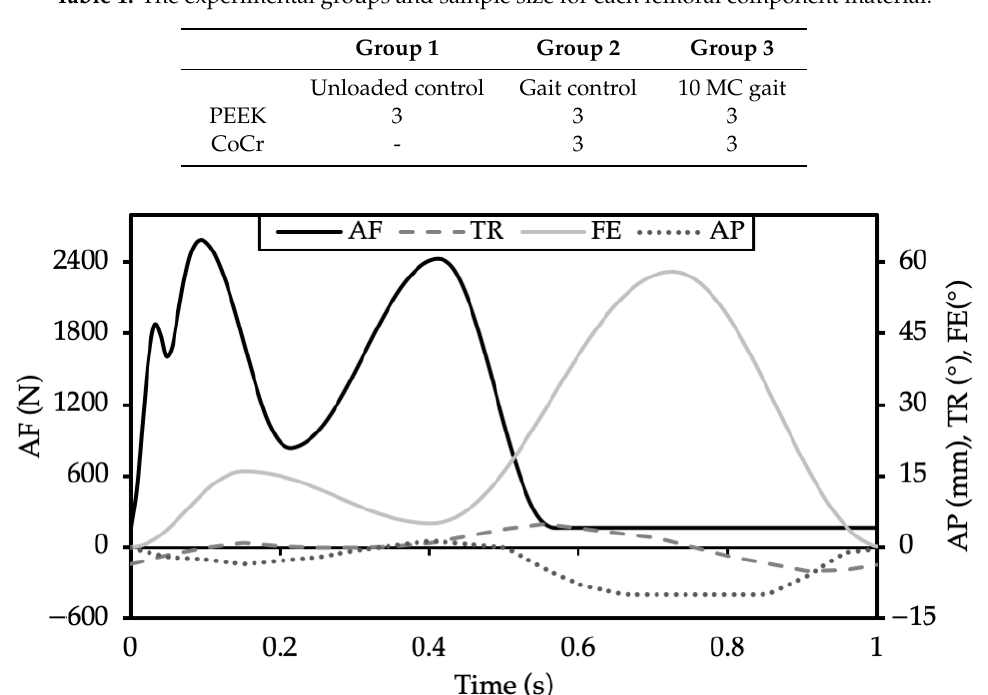
Table 1. The experimental groups and sample size for each femoral component material.